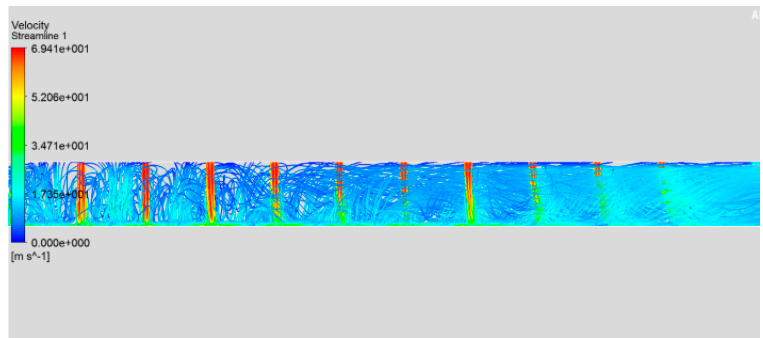
Figure 17. Side view of streamline development.